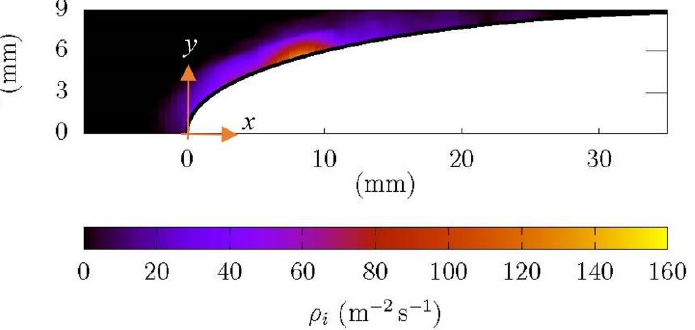
Figure 9. Collision density between rebounding and incoming droplets on NACA 0012 profile, super-hydrophobic surface.